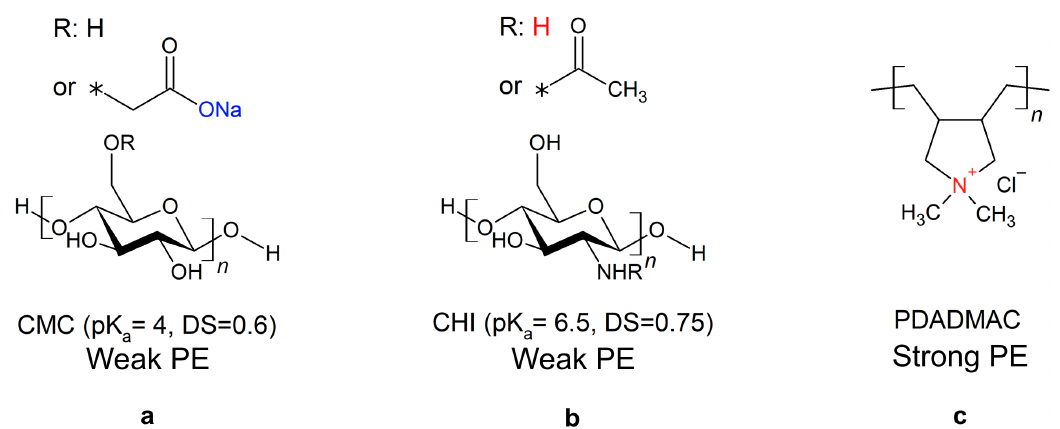
Figure 1. Molecular structures of the polyelectrolytes (PEs) used. The asterisk indicates on which position the functional group is attached to the polyelectrolyte, e.g., for CMC the asterisk represents the oxygen of the primary hydroxyl group. The negatively charged group of carboxymethyl cellulose (CMC) ( a ) is depicted in blue and the positively charged groups of chitosan (CHI) ( b ) and polydiallyldimethylammonium chloride (PDADMAC) ( c ) in red. For the weak PEs, the pK a -value and the degree of substitution (DS) are